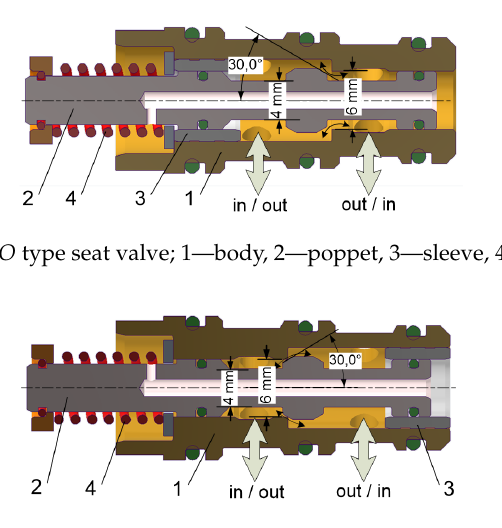
Figure 5. NC type seat valve; 1—body, 2—poppet, 3—sleeve, 4—spring.